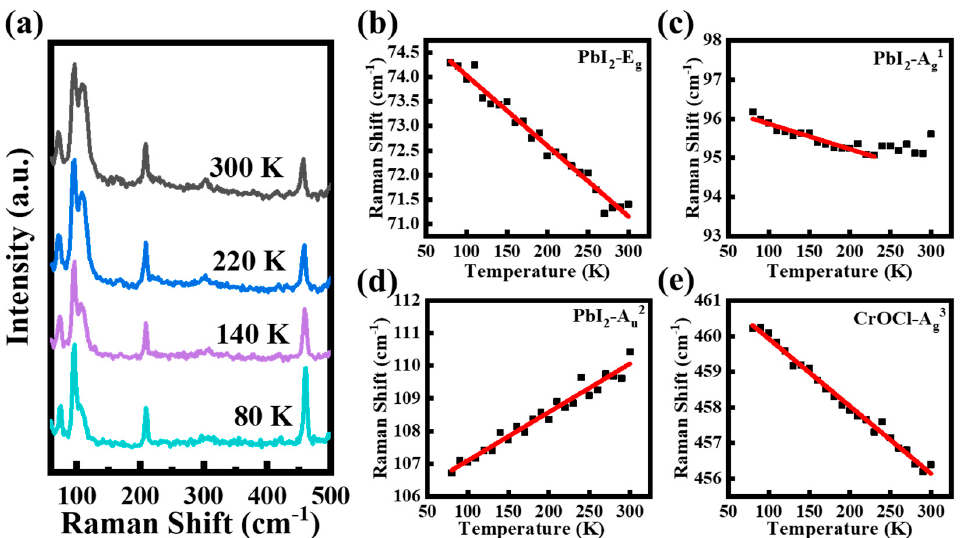
Figure 4. Temperature − dependent Raman spectra of PbI 2 /CrOCl heterostructure. ( a ) Selected and normalized Raman spectra of PbI 2 /CrOCl heterostructure at selected temperatures. Temperature dependence of peak position of E g ( b ), A 1 g ( c ) and A 2 u ( d ) modes in PbI 2 . ( e ) Temperature dependence of peak position of A 3 g mode in CrOCl. The solid red lines represent the linear fitting results.